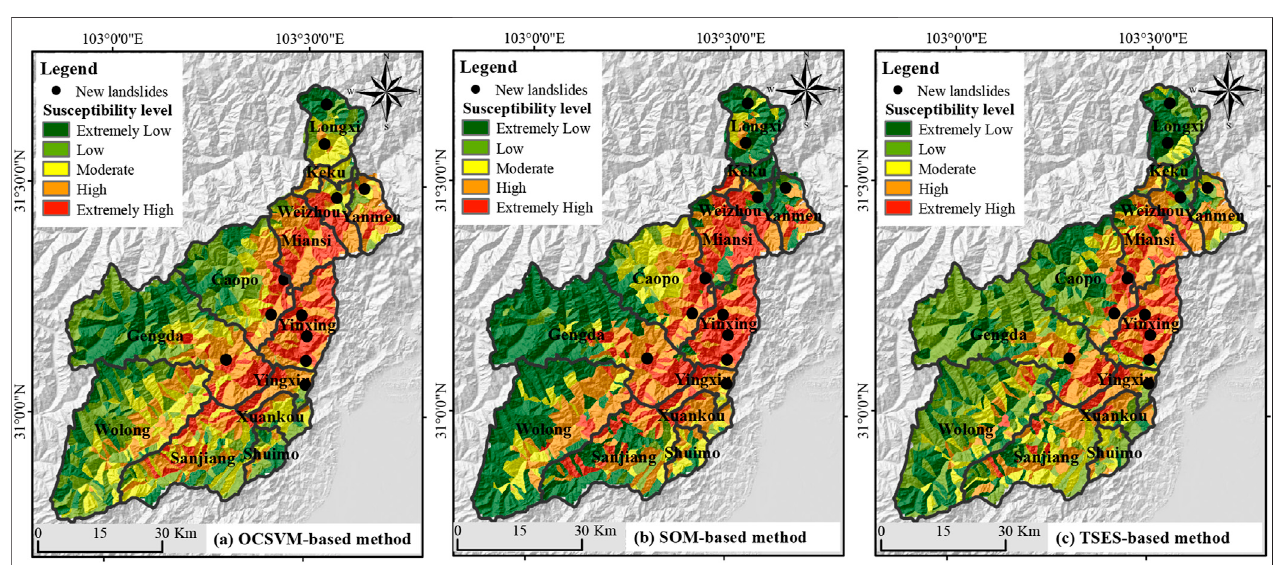
FIGURE 9 | Landslide susceptibility maps produced by: (A) OCSVM-based method, (B) SOM-based method, and (C) TSES-based method.